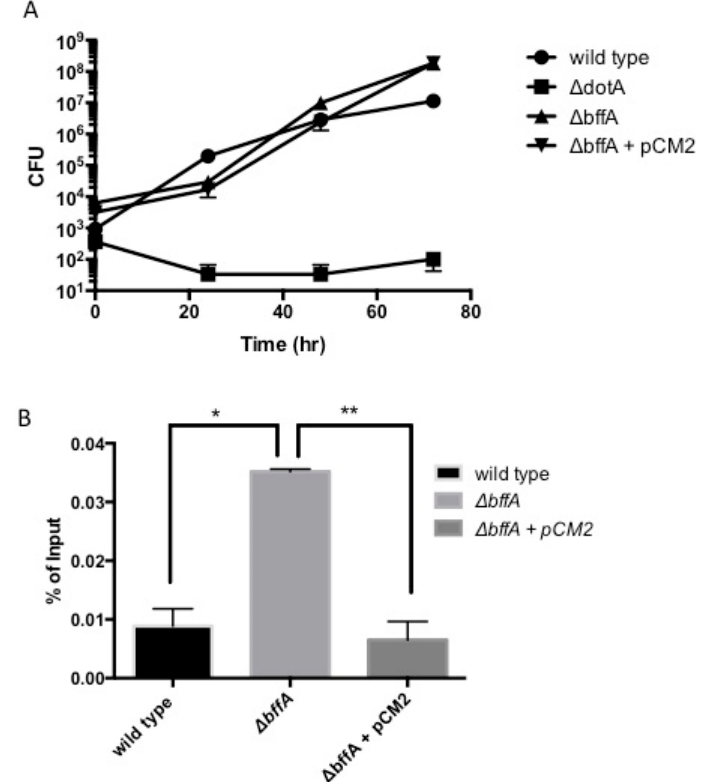
Figure 2. ∆ bffA has normal intracellular growth but enhanced uptake into amoebae . Intracellular growth in amoebae was tested using a 72-hour amoebae growth curve ( A ). To test the enhanced uptake, we performed a gentamicin protection assay ( B ) . * p < 0.05, ** p < 0.005 Experiments are an average of three repetitions.